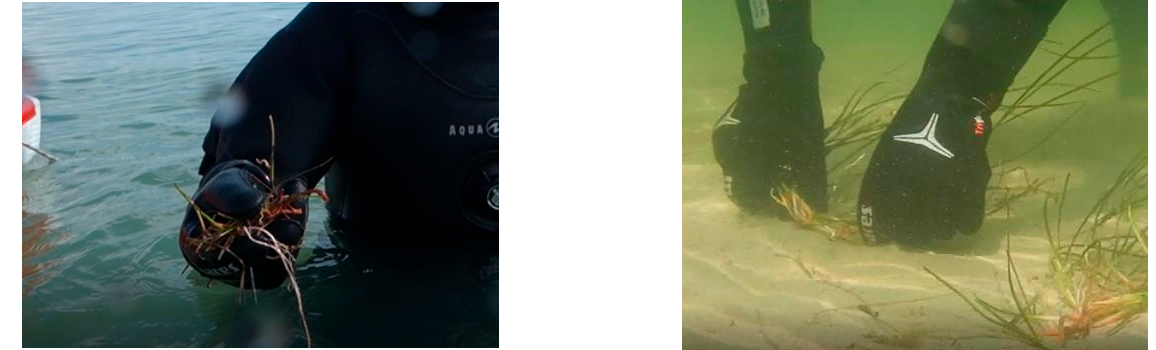
Figure 10. Panzano Bay (Gulf of Trieste) pilot transplantation by plant cuttings, inserted into the substrate by means of